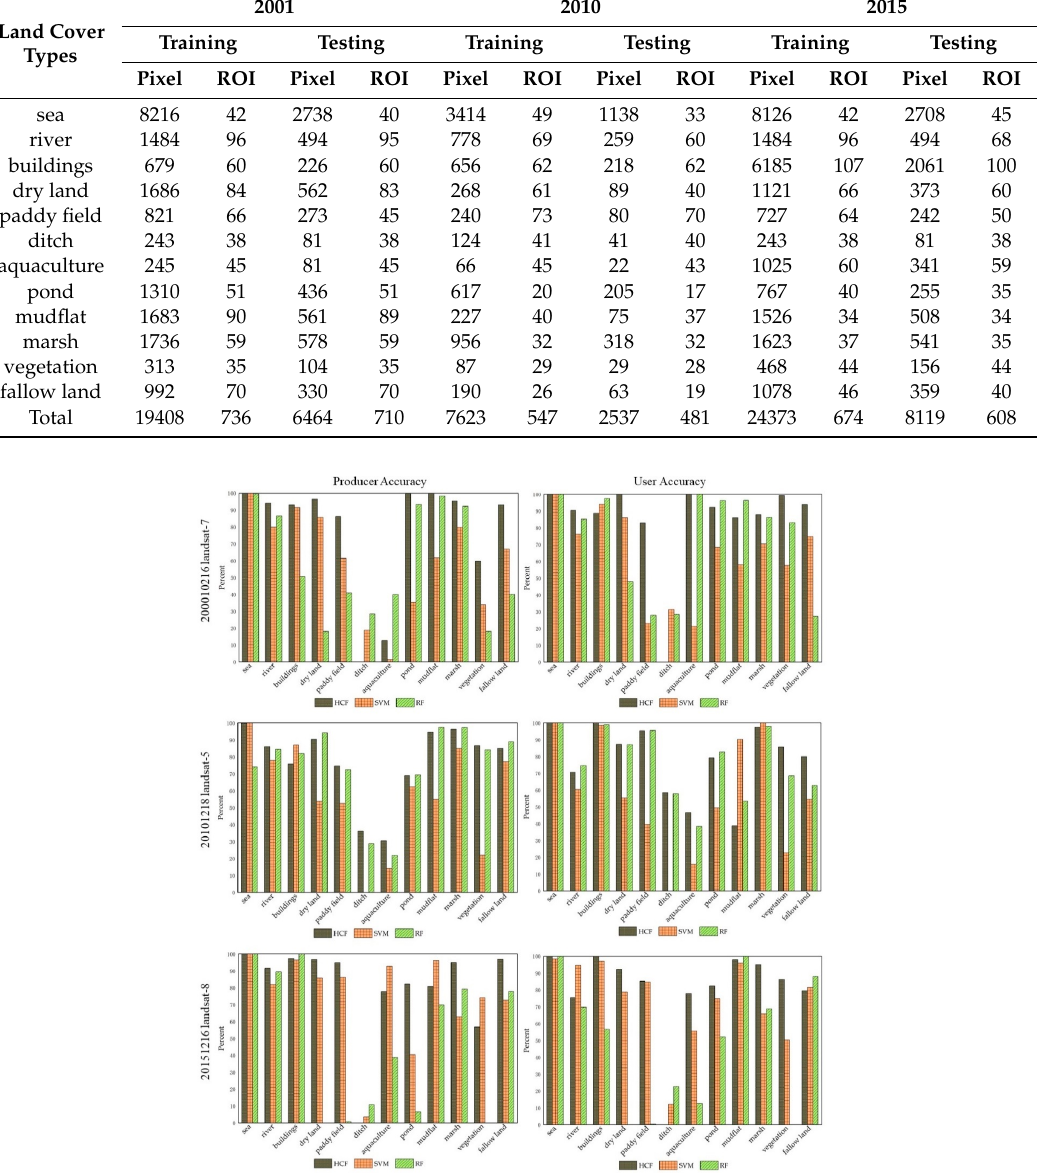
Figure 5. The comparison of PA and UA between HCF, SVM and RF on Yancheng coastal wetland.